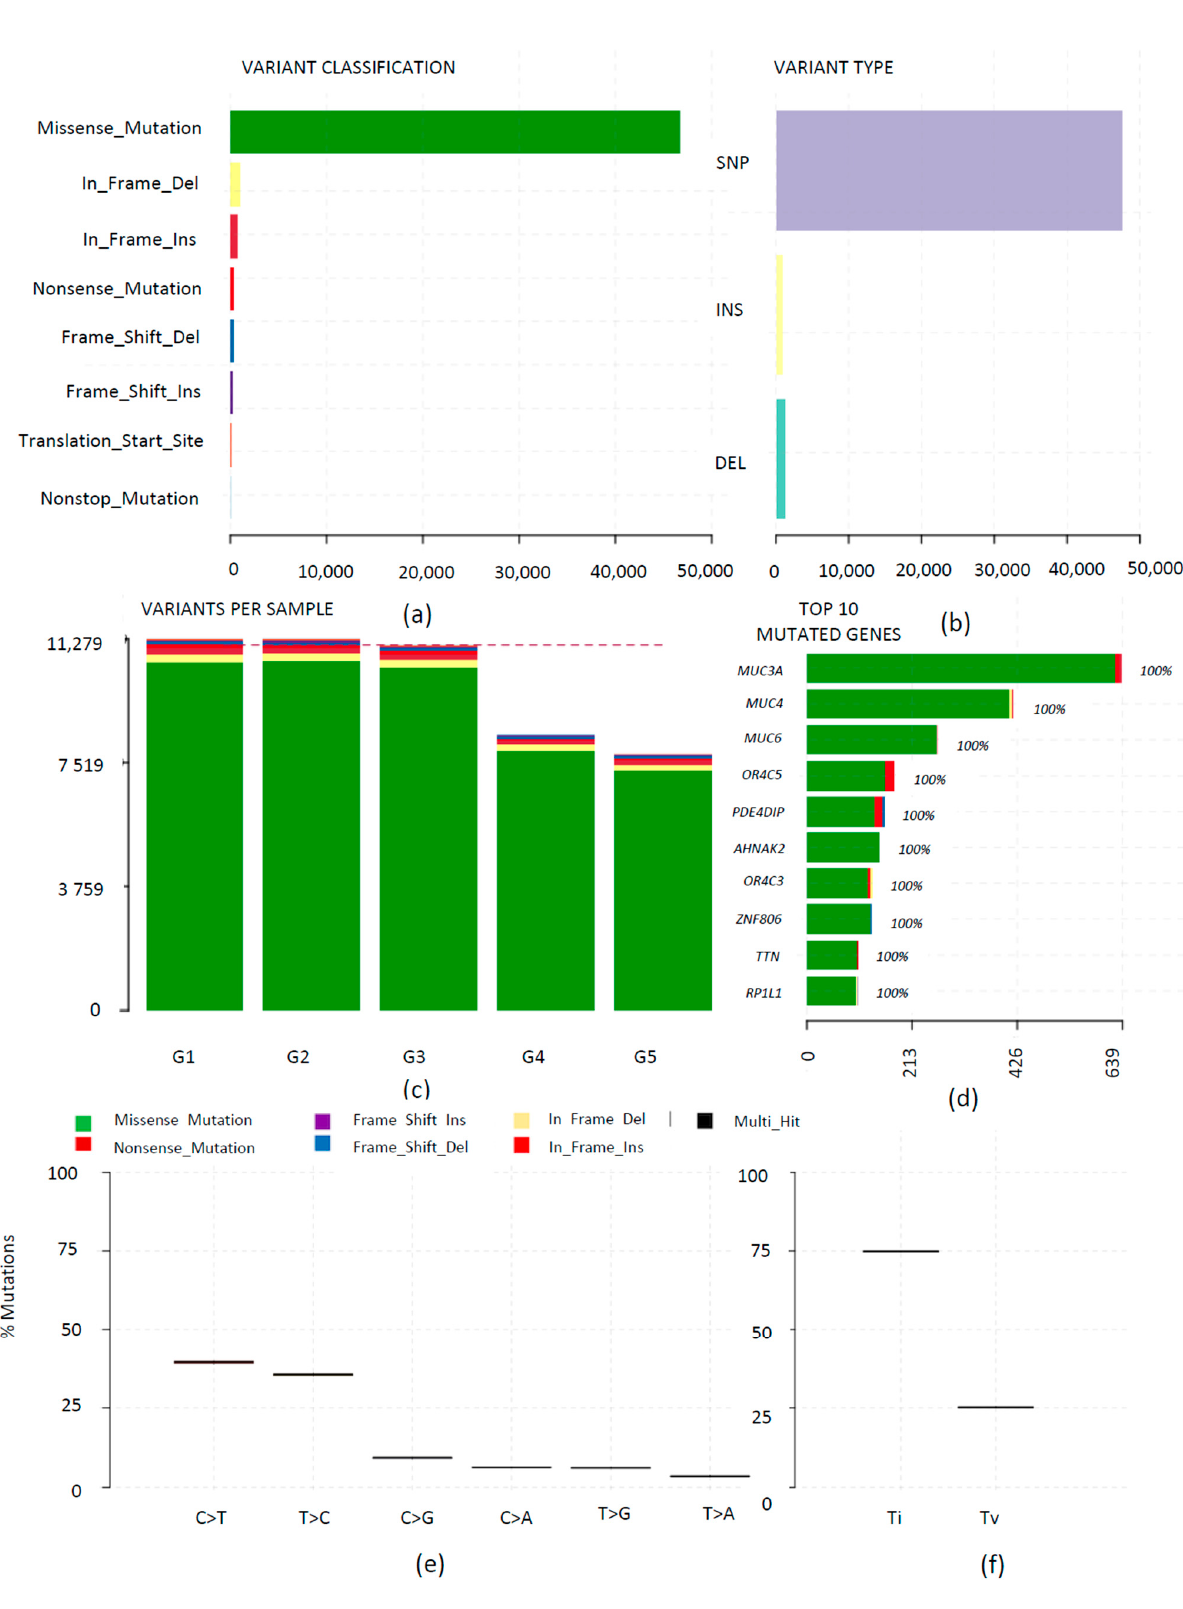
Figure 7. Landscape of 49,780 somatic mutations (not considering synonymous mutations) iden- tified across the five samples by use of Maftools. ( a ) Distribution of different types of mutations. ( b ) The number of different missense mutations. ( c ) Variants observed for each sample. ( d ) Highly mutated genes based on the number of mutations per gene. ( e ) Overall distribution of six different transition/transversion conversions. ( f ) Fraction of transition-transversion (TiTv)